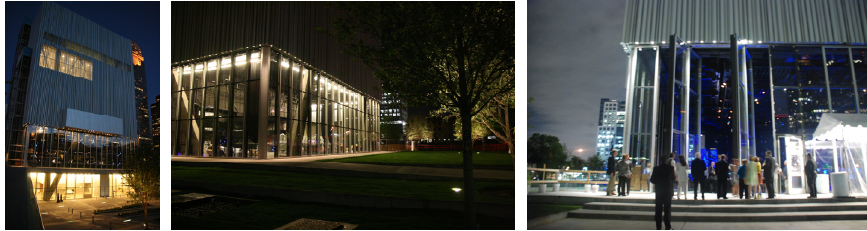
Figure 8a, b, c: Theater Night Views – Entry Wall, Theater Wall, Operable Wall (3m x 9m – STC